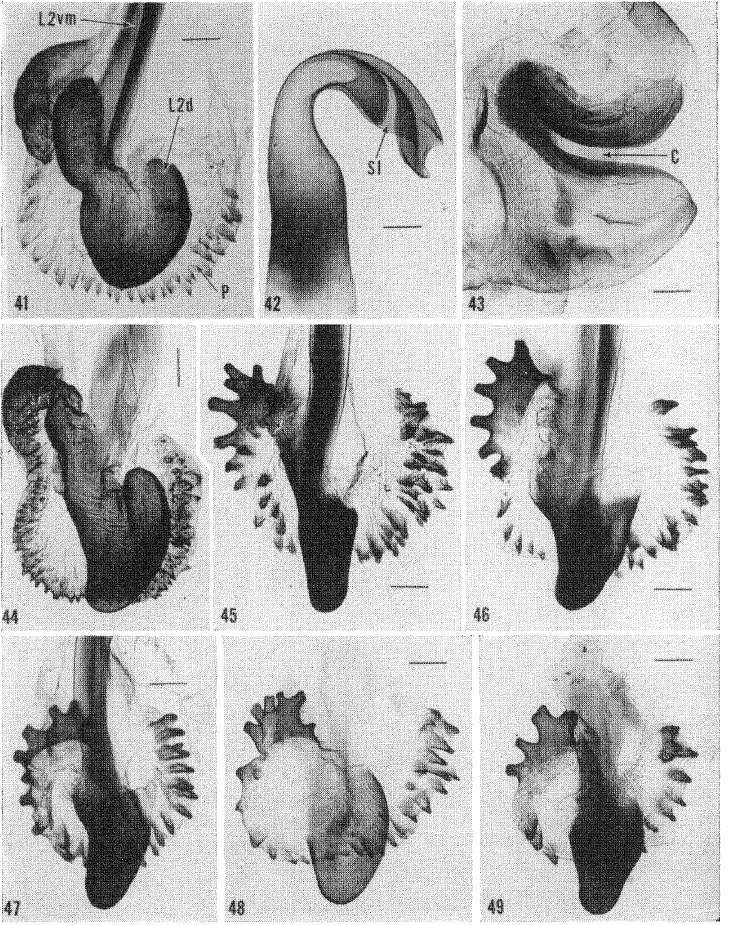
--- Figs. 41-49. 41-43. Blaberus giganteus. 41. (1 AMNH). Caripito, Vene- zuela. (L2d dorsal left phallomere; L2vm ventromedial left sclerite; P prepuce.) 42-43. (27 ANSP). Muzo, Colombia. (det. Roth). (SI Subapical incision of hooked right phallomere R2; C--- Cleft of left phallomere L1). 44. (46 USNM). Blaberus craniifer. Cordoba, Mexico. (det. Roth). 45. (34 USNM). Blaberus atropos. Charleston Quarantine (? Colombia) (det. Roth). 46. (6 AMNH). Blaberus parabolicus. San Martin, Peru (det. Roth). 47. (N). Blaberus discoidalis. Panama (det. -- Roth). 48. (514 L). Blaberus anisitsi. (from specimen shown in Fig. 7). 49. (516 L). Blaberus bolivicnsis. (from specimen shown in Fig. 6). (scale 0.3